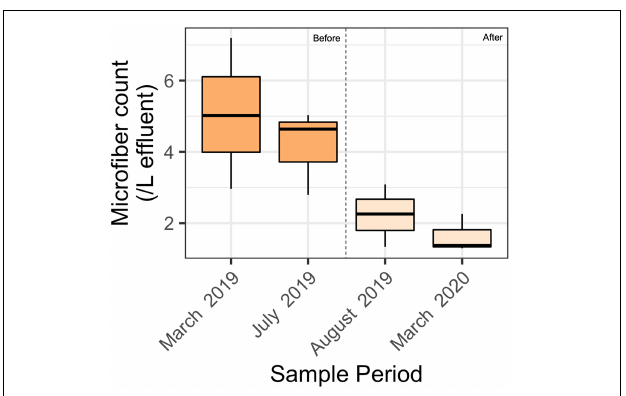
FIGURE 4 | Boxplot showing microfiber count for each sample period before the filter installation (March 2019 and July 2019) and after filter installation (August 2019 and March 2020). Results presented here are after blank subtractions. A 2-factor ANOVA showed a significant difference before and after filter installation (* p < 0.01), and no significant difference amongst seasons ( p = 0.8) or the filter-season interaction ( p = 0.4). The middle black bar represents the median, and each box represents the first to third quantile of the data. The whiskers represent the minimum and the maximum number of fibers/L of the sample.